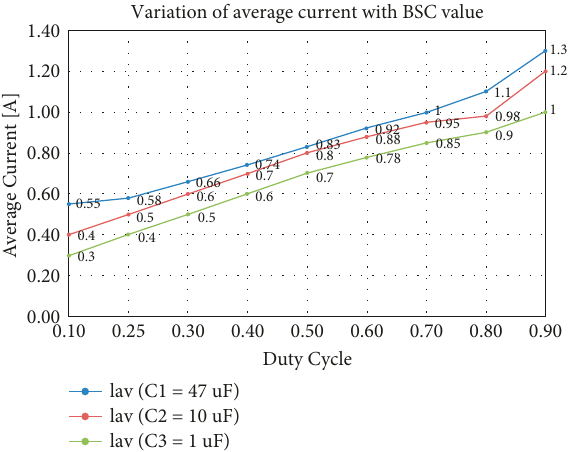
Figure 17: The average load current at different BSC values (500